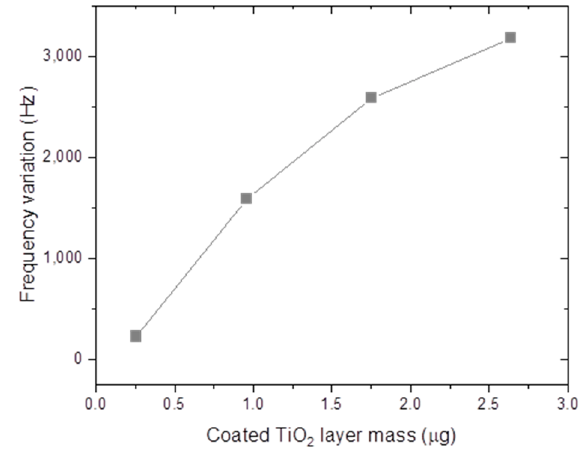
Figure 12. Effect of coating layer mass on the frequency response of MES. Figure 12. E ff ect of coating layer mass on the frequency response of